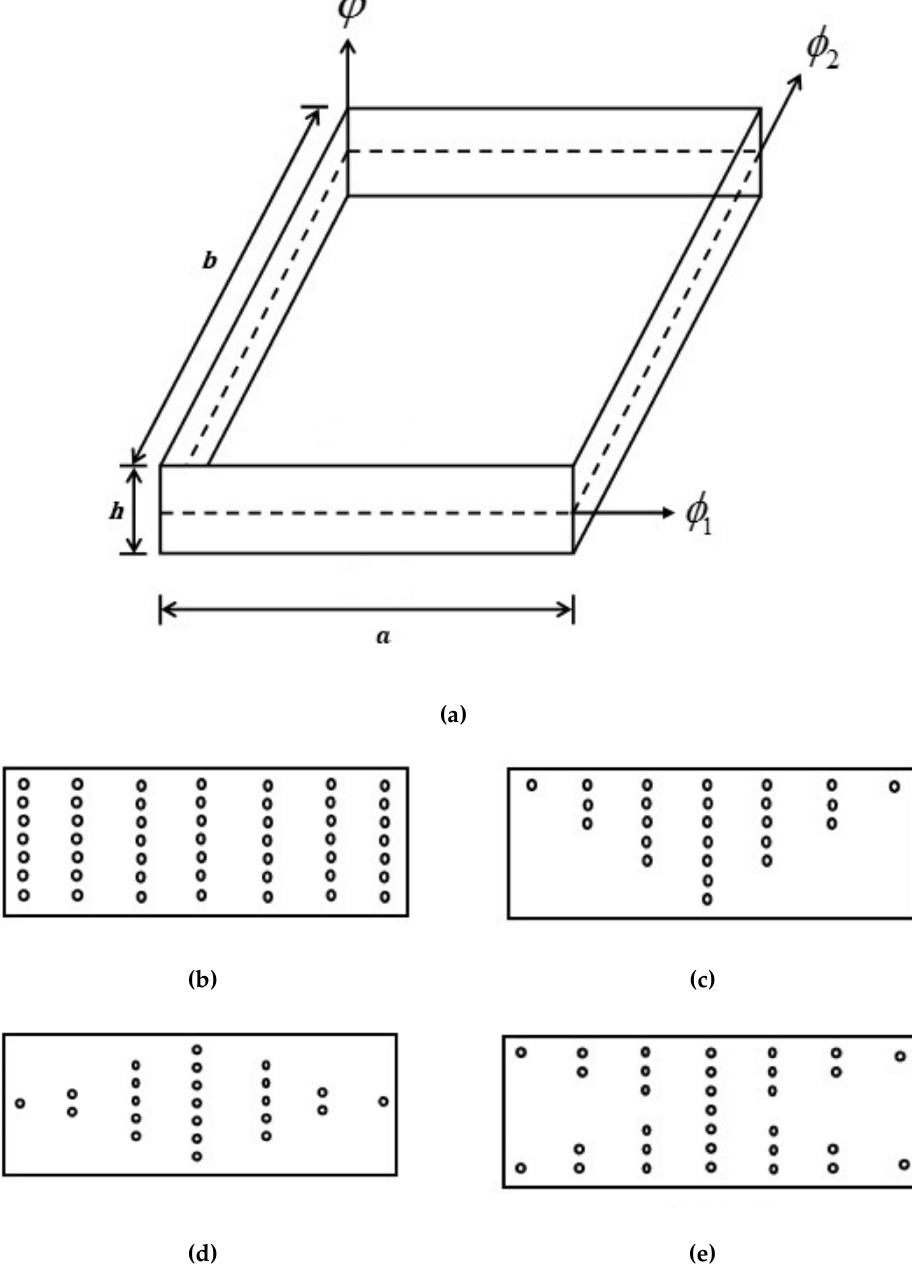
Figure 1. Configuration of carbon nanotube reinforced functionally graded plates. ( a ) Geometry of CNT-reinforced plate; ( b ) UD; ( c ) FG - V; ( d ) FG - O; ( e ) FG - X.